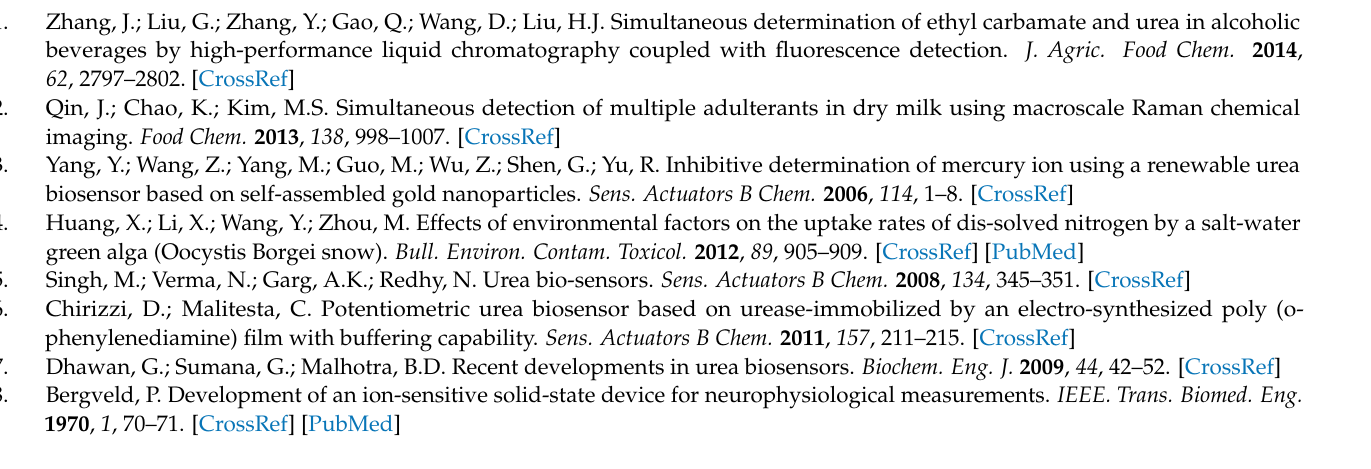
Figure 11. Change in the reference voltage for the TG, BG, and SG modes of the triple-gate a-IGZO TFT-based urea-EnFET sensor platform as a function of pUrea in the ( a ) R1, ( b ) R2, and ( c ) R3 regions. Table 4. Comparison of the analysis characteristics of the proposed urea-EnFET sensor platform and previously reported ISFET-based urea sensors.